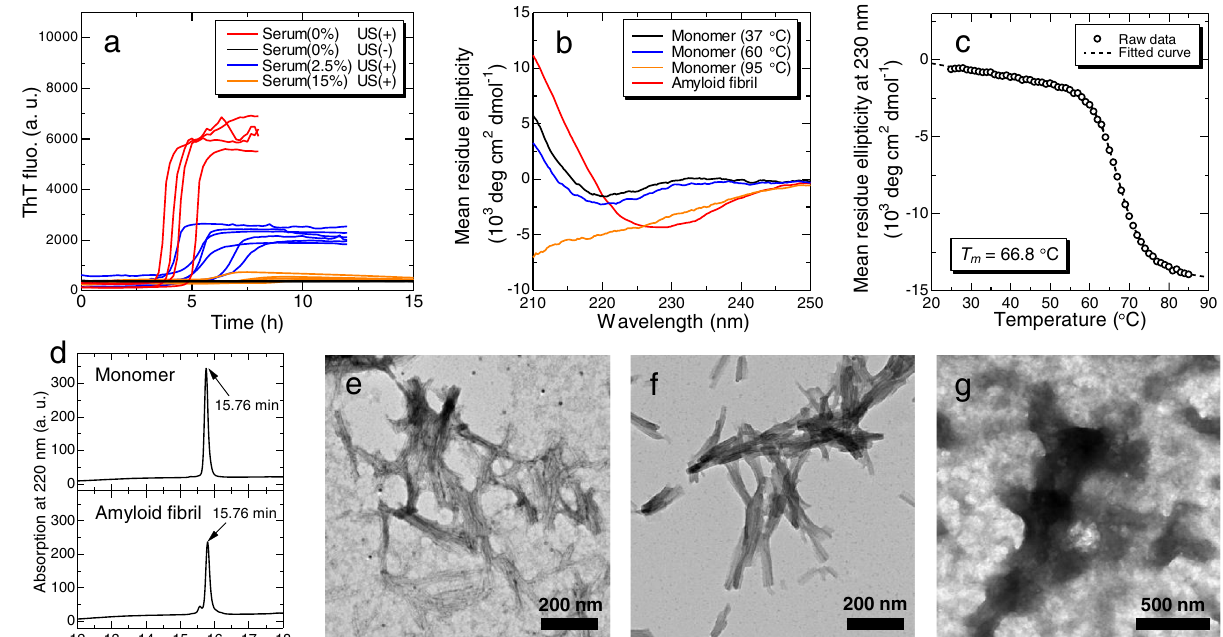
Fig. 1 | HANABI assay for β 2m amyloid fi bril formation. a ThT fl uorescence kineticsof β 2msolutionsatvariousconditions( n ≥ 4).Serumwascollectedfroma non-dialysiscontrol#9(DT( − )). b CDspectraoftheinitialmonomersat37,60,and 95°C, and amyloid fi brilsformedby ultrasonication. c Thermaldenaturation curve of β 2mmonomermonitoredbytheCDellipticityat230nm. T m isthedenaturation midpoint obtained from the fi tted curve. d High performance reversed-phase chromatograms for intact monomers (upper) and amyloid fi brils formed by